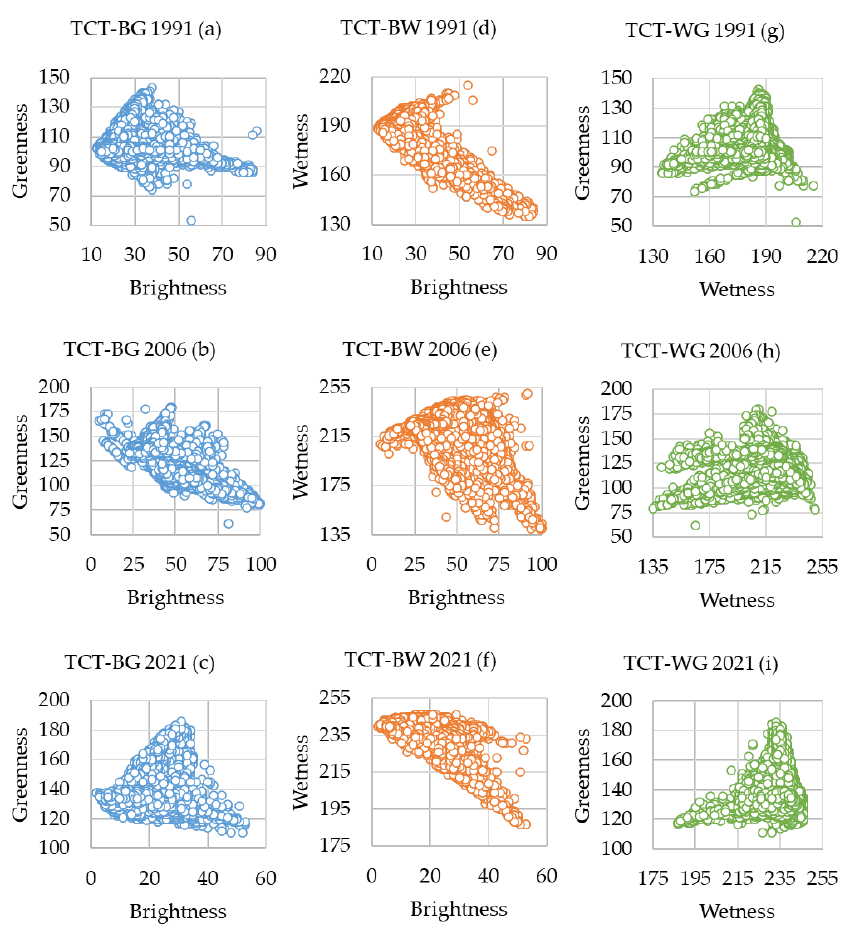
Figure 10. Onshore TCT change comparisons: ( a ) TCT-BG of 1991, ( b ) TCT-BG of 2006, and ( c ) TCT-BG of 2021, ( d ) TCT-BW of 1991, ( e ) TCT-BW of 2006, and ( f ) TCT-BW of 2021, ( g ) TCT-WG of 1991, ( h ) TCT-WG of 2006, and ( i ) TCT-WG of 2021.